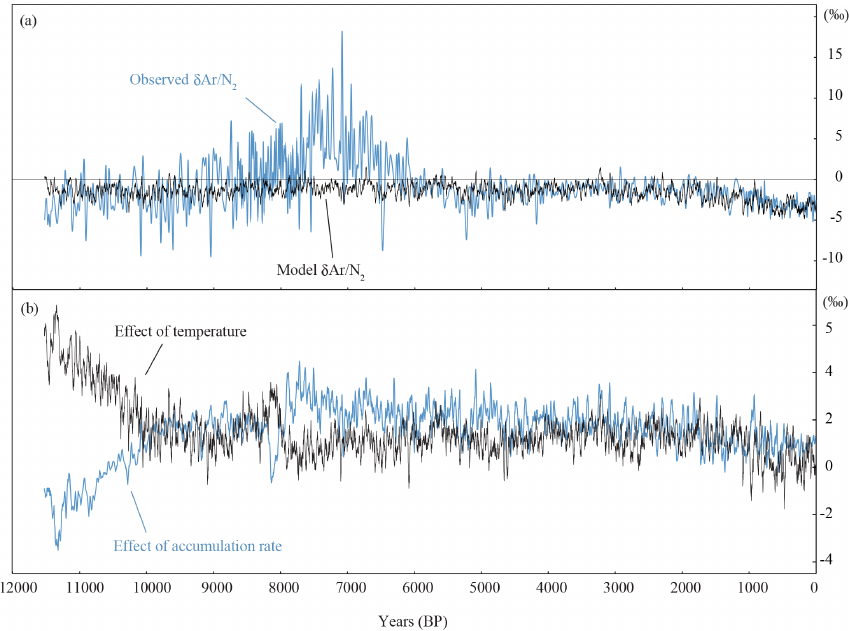
Figure 6. Observed and modeled δ Ar / N 2 over the Holocene, and decomposition of δ Ar / N 2 into the effects of accumulation rates and temperatures. Note that the observed δ Ar / N 2 are corrected values for the post-coring fractionation (1.5‰ added). (a) Observed and modeled δ Ar / N 2 . (b) Decomposition of δ Ar / N 2 into the effects of temperatures and accumulation rates using multiple linear regression (see